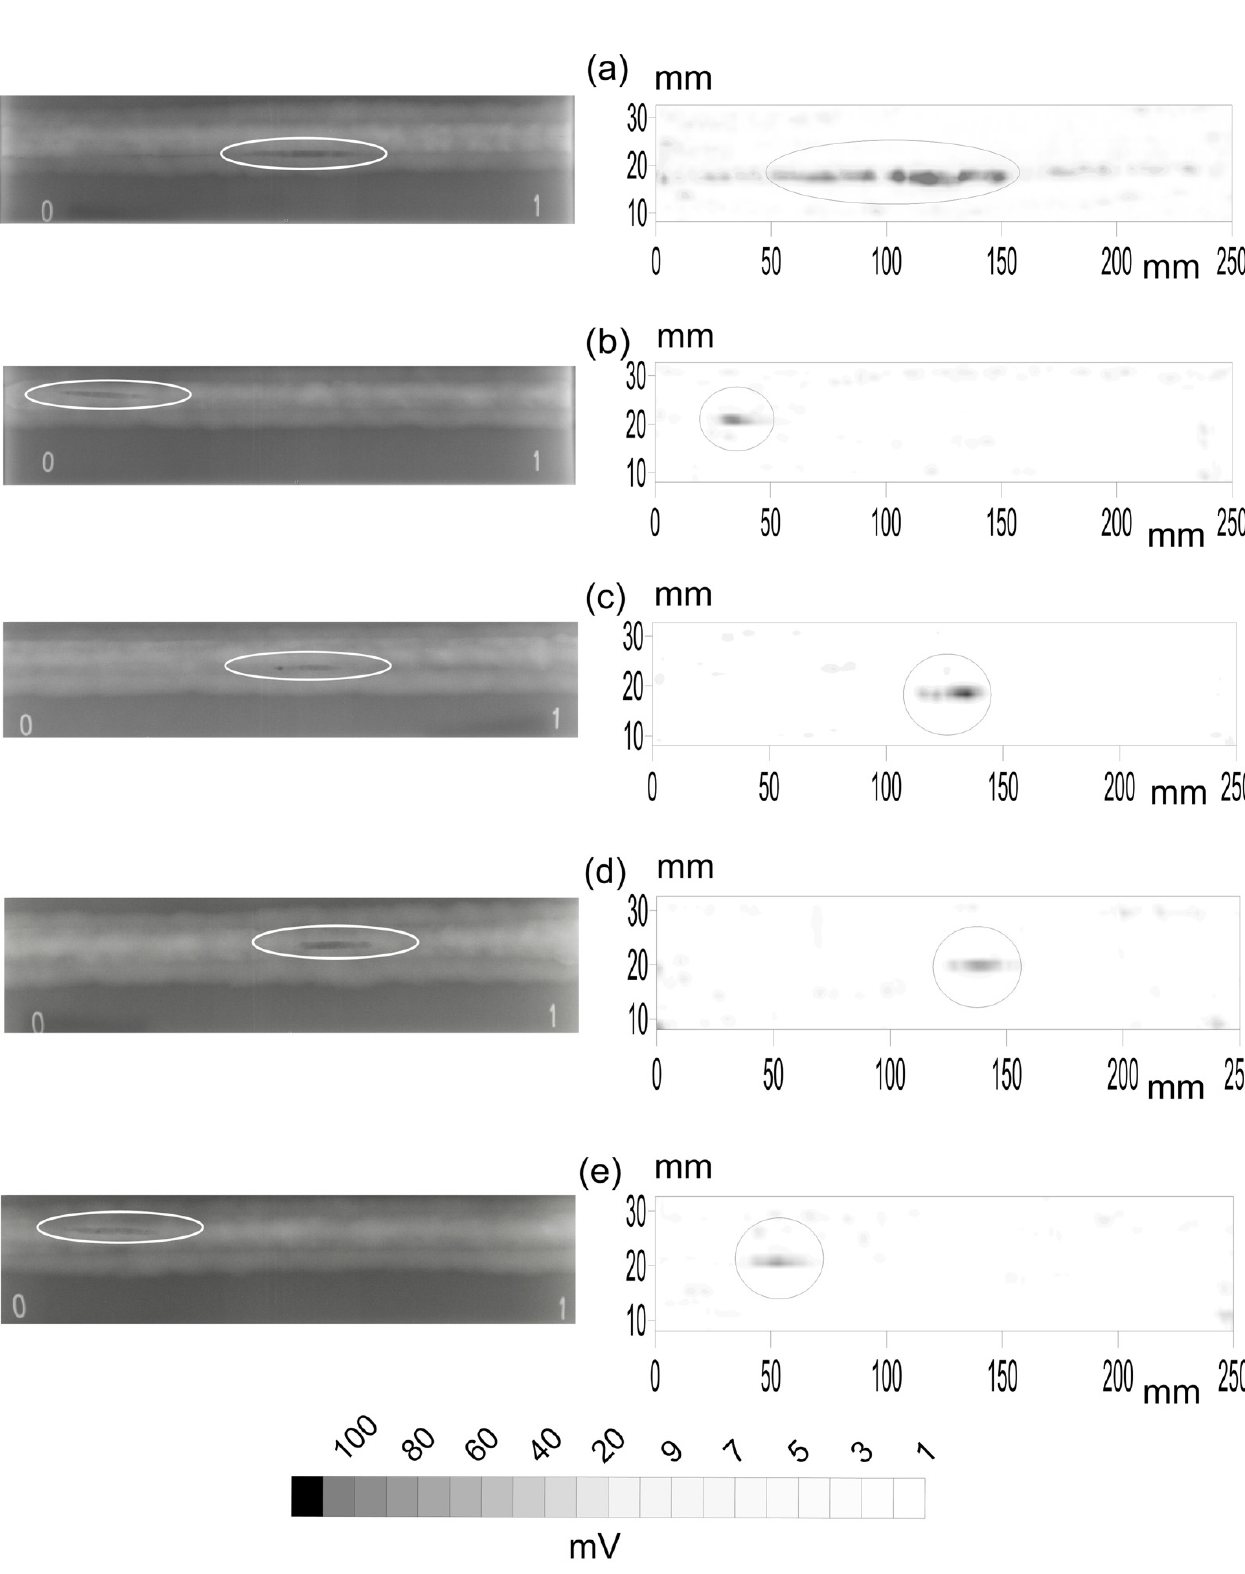
Figure 5. X-ray ( left ) and phased array inspection ( right ) of five specimens, ( a – e ), with slag intrusion. The length of the specimen is 250 mm and their width is 30 mm with the axis of the weldment in the middle. The small numbers 0 and 1 in the X-rays images were added when inspected.